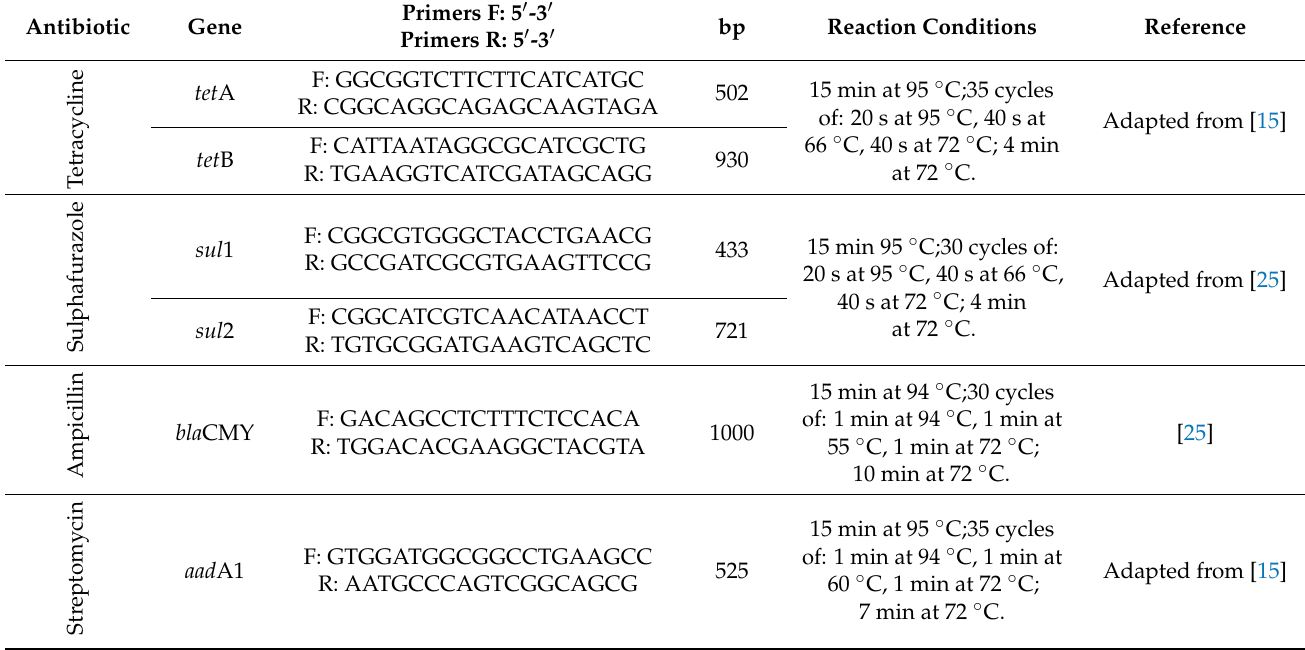
Table 3. PCR conditions for detection of the selected antibiotic resistance genes.